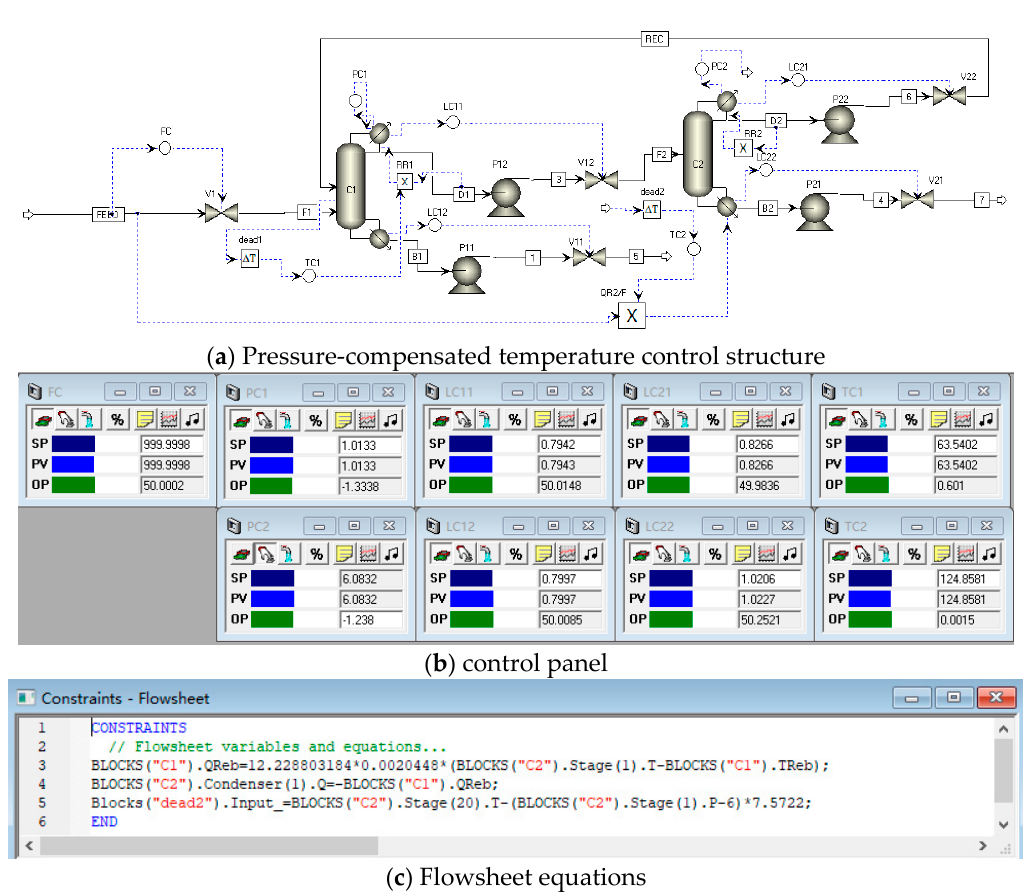
Figure 18. Pressure-compensated temperature control structure of flowsheet, control panel, and flowsheet equations.